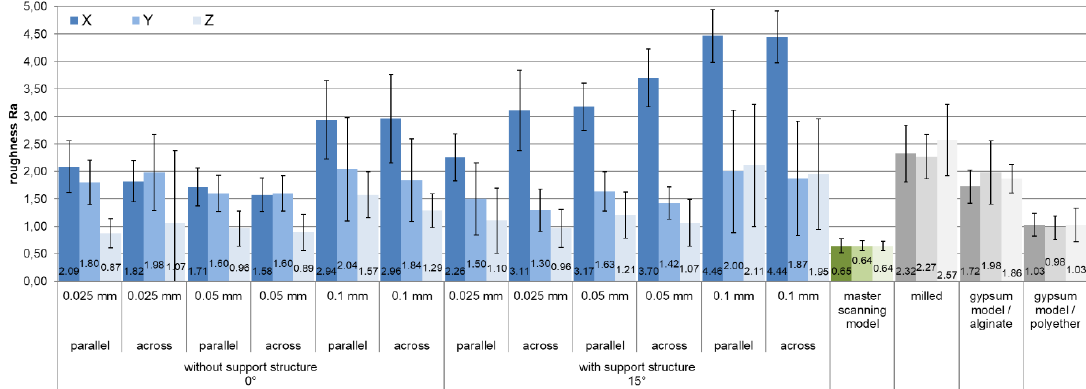
Figure 5. Mean values of surface roughness Ra as a function of various printing parameters in comparison with the reference models and the master model; all dimensions are in µ m. X, Y, Z: measurement directions (see Figure 4, values of the measurement directions X1 / X2, Y1 / Y2, and Z1 / Z2 were summarized); parallel / across: models’ alignment to the printer’s front (see Figure